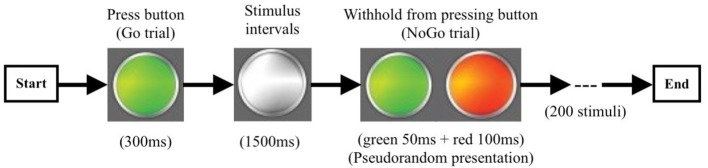
The procedure of the go/no-go experiment. Go trail (green light): 300 ms/per stimulus, 150 times; No-go trail (green + red light): 150 ms/per stimulus, 50 times; Stimulus Intervals 1,500 ms.